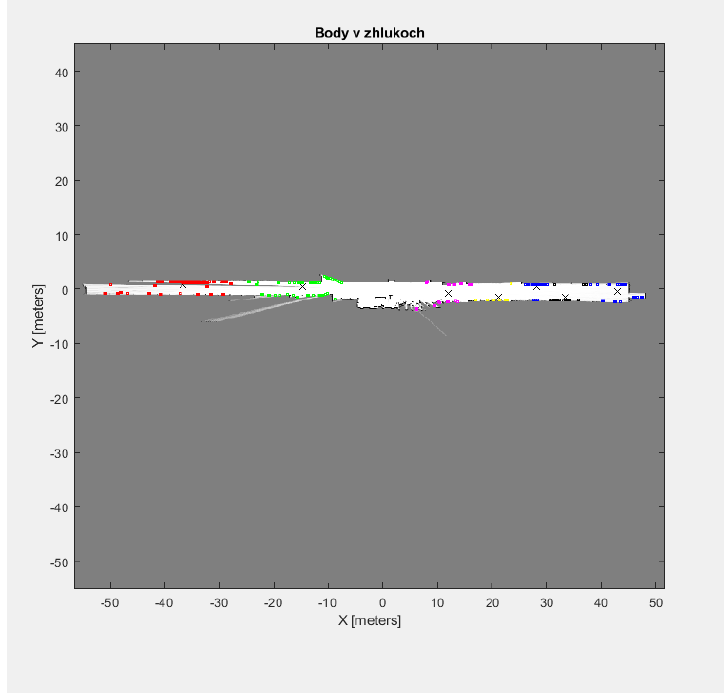
Figure 9. Points in a cluster on a grid map.